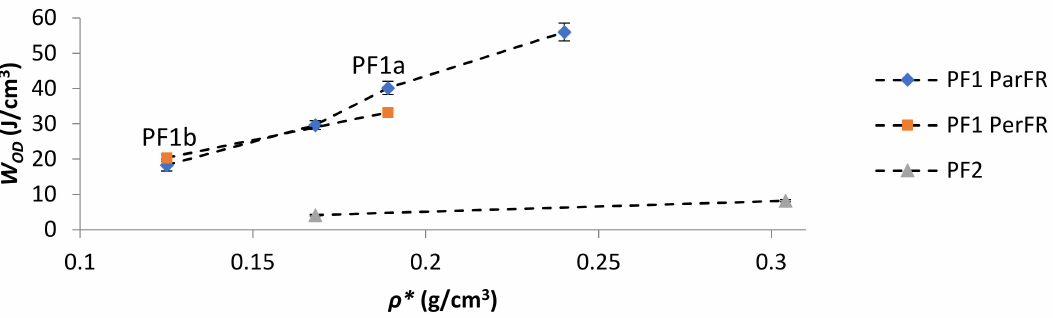
Figure 11. W OD as a function of ρ *.